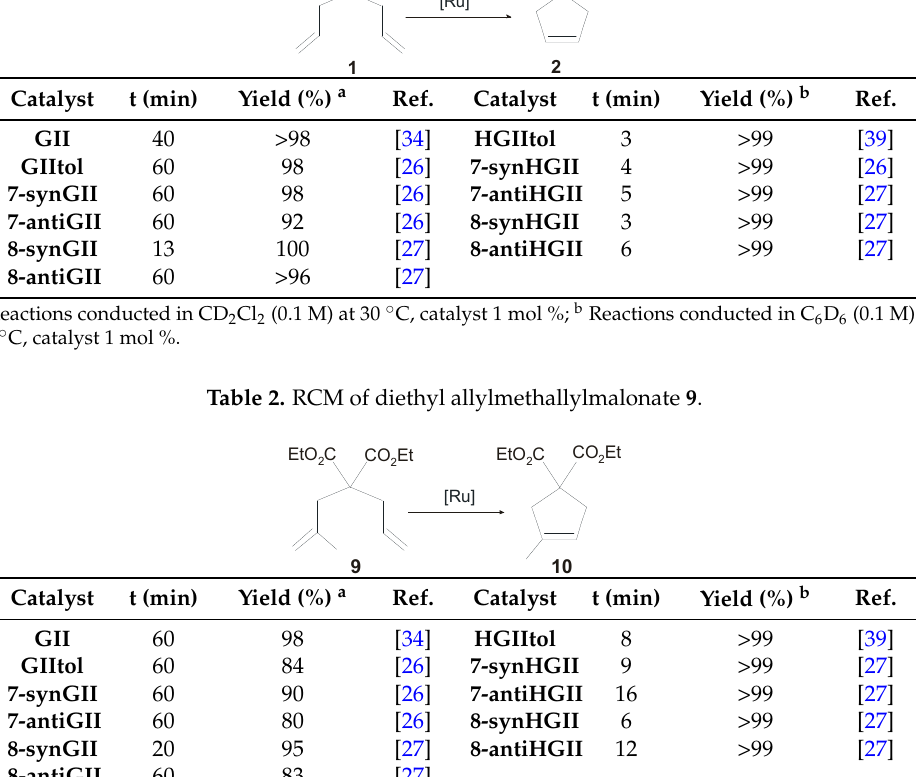
Table 1. RCM of diethyl diallylmalonate 1 .